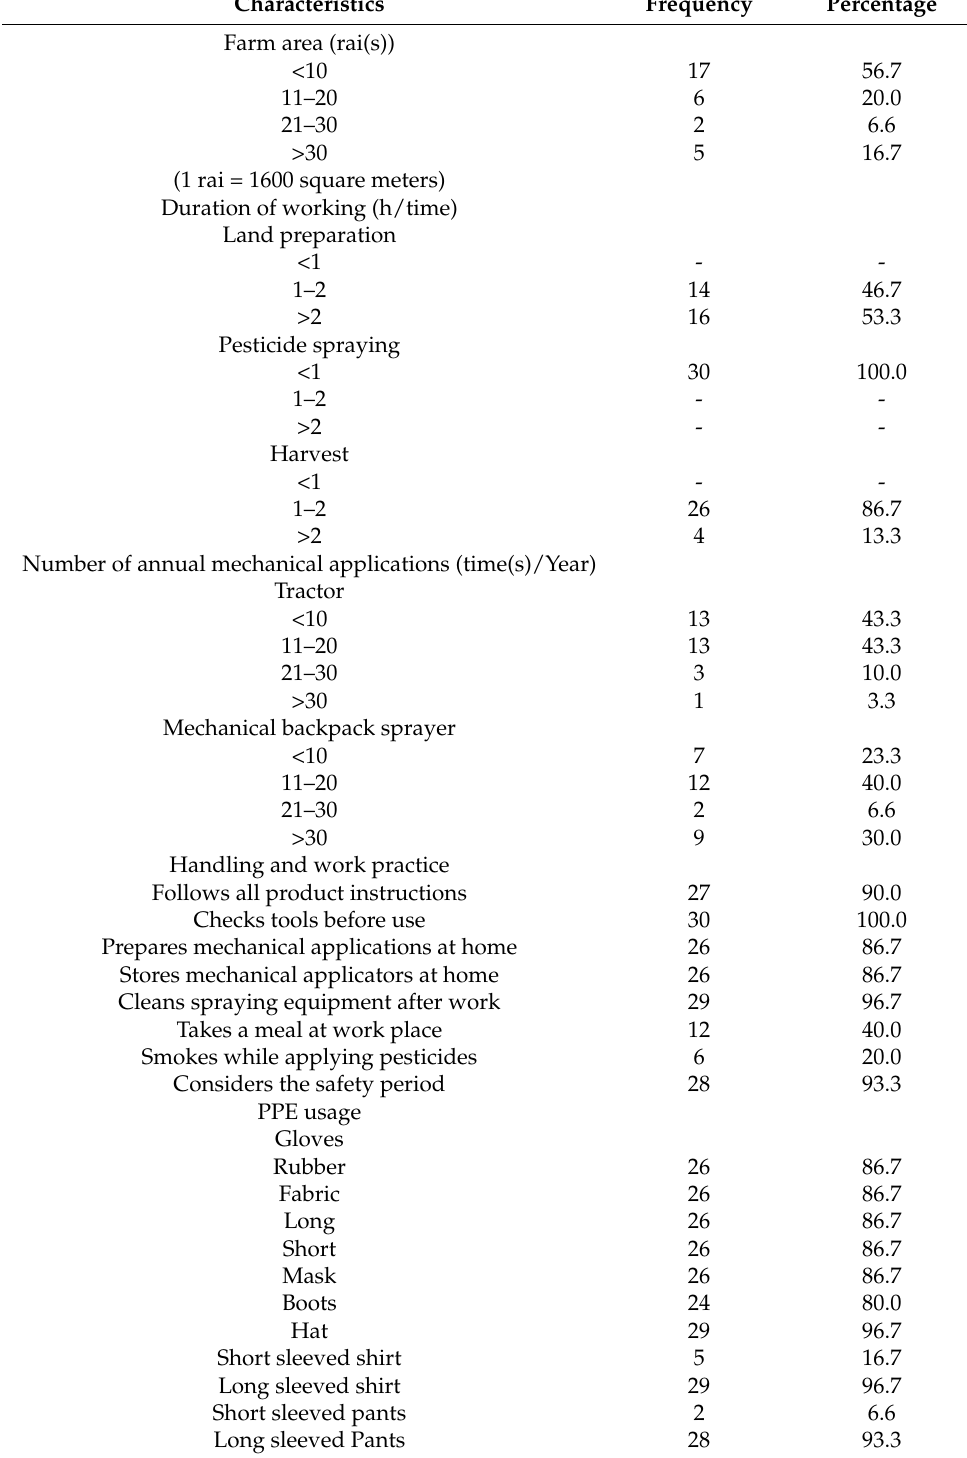
Table 2. Farm and work practices ( n =